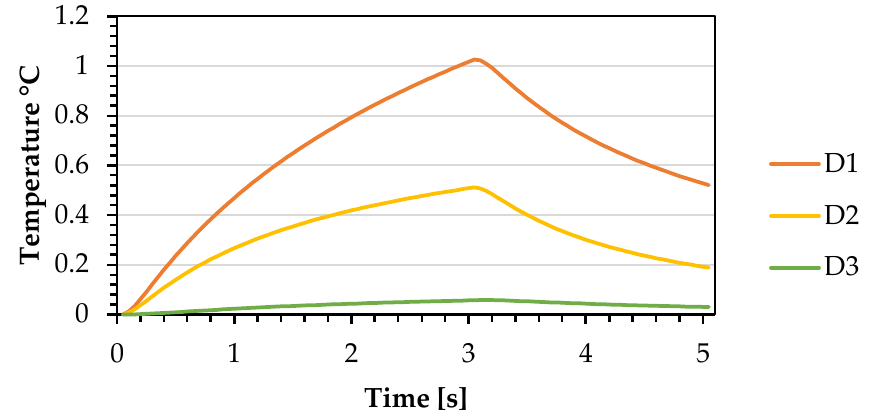
Figure 9. The course of temperature changes on the sample surface over the defects (location of the center of the vibration transducer x = 40, y = 50).